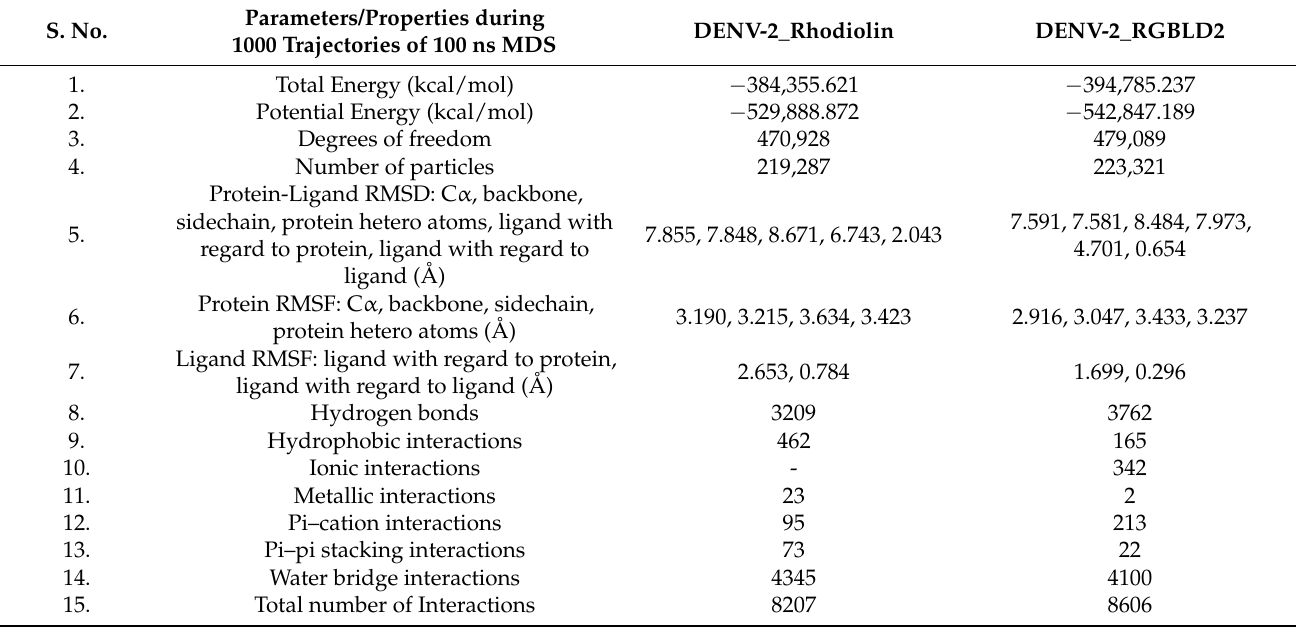
Table 7. Comparison of scores obtained in the molecular dynamic’s simulation parameters for DENV-2 reference molecule and novel analog